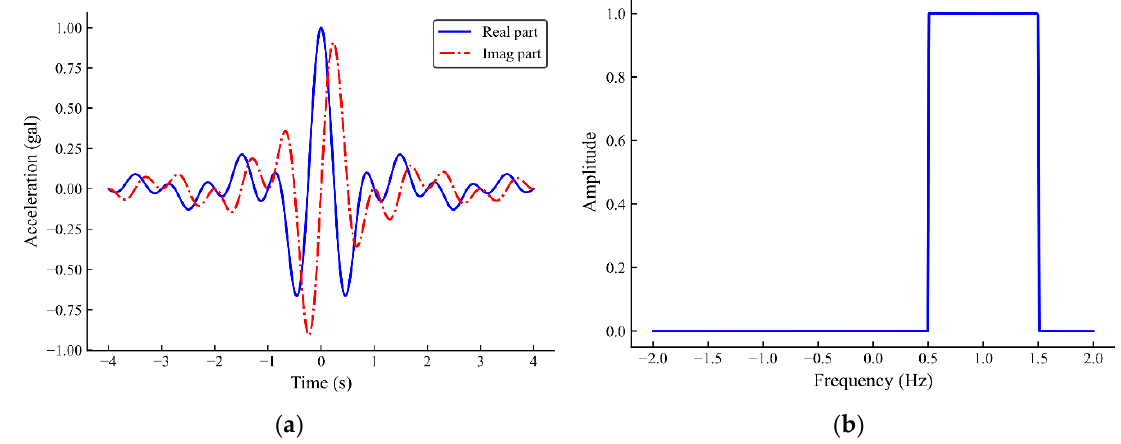
Figure 1. ( a ) Time and ( b ) frequency characteristics of complex Shannon wavelet basis.